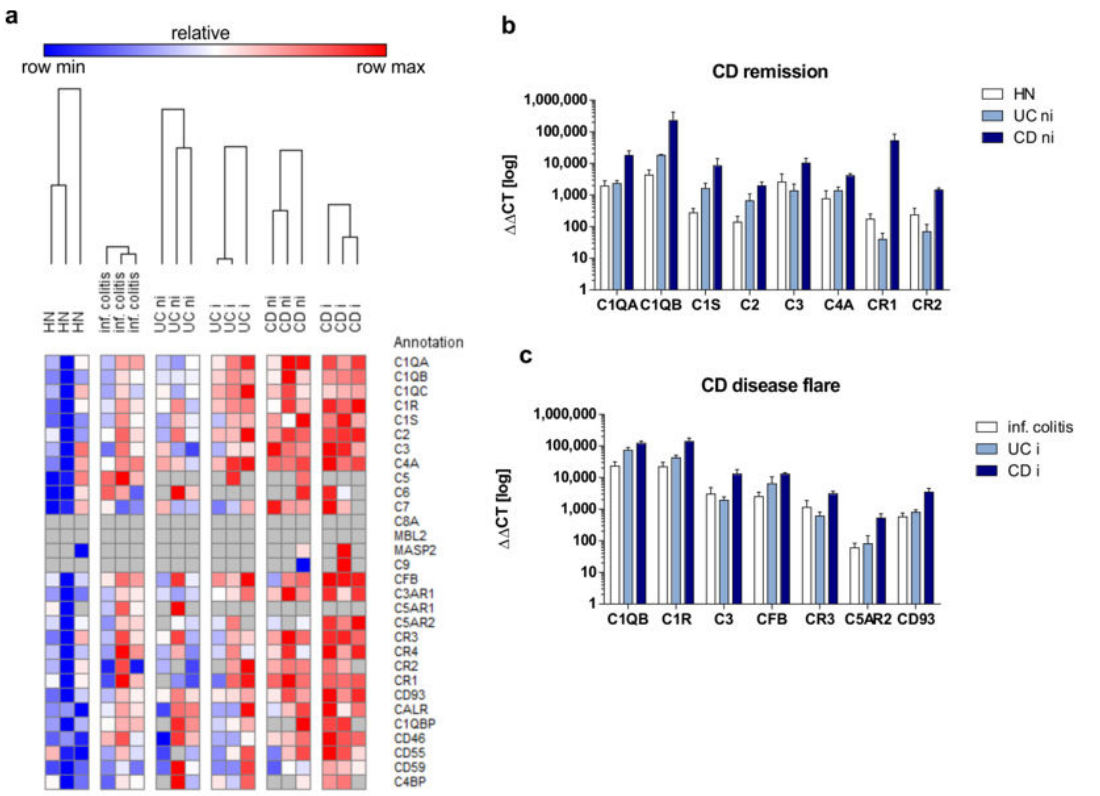
Figure 1. Complement components are more frequently expressed in Crohn’s disease (CD) patients than in ulcerative colitis (UC) patients. Real-time PCR analysis was performed utilizing customized TaqMan array plates for parallel amplification of 30 human complement components in non-inflamed in remission (ni) and inflamed (i) sigmoidal biopsy samples from CD and UC patients as well as from hospitalized normals (HN). Relative ddCt values are depicted in a heatmap ( a ) and subdivided into significantly regulated transcripts in remission state ( b ) or in active disease state ( c ). Results are expressed as means ±